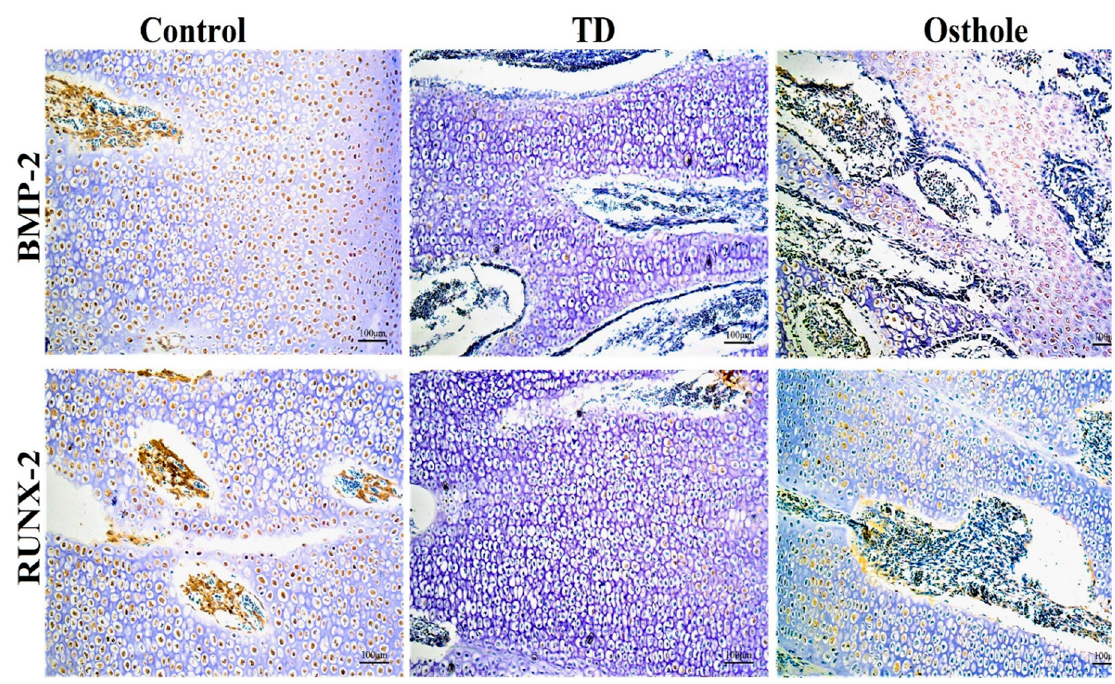
Figure 10. Immunohistochemical localization of BMP-2 and RUNX-2 antibodies in the control, TD, and osthole groups.